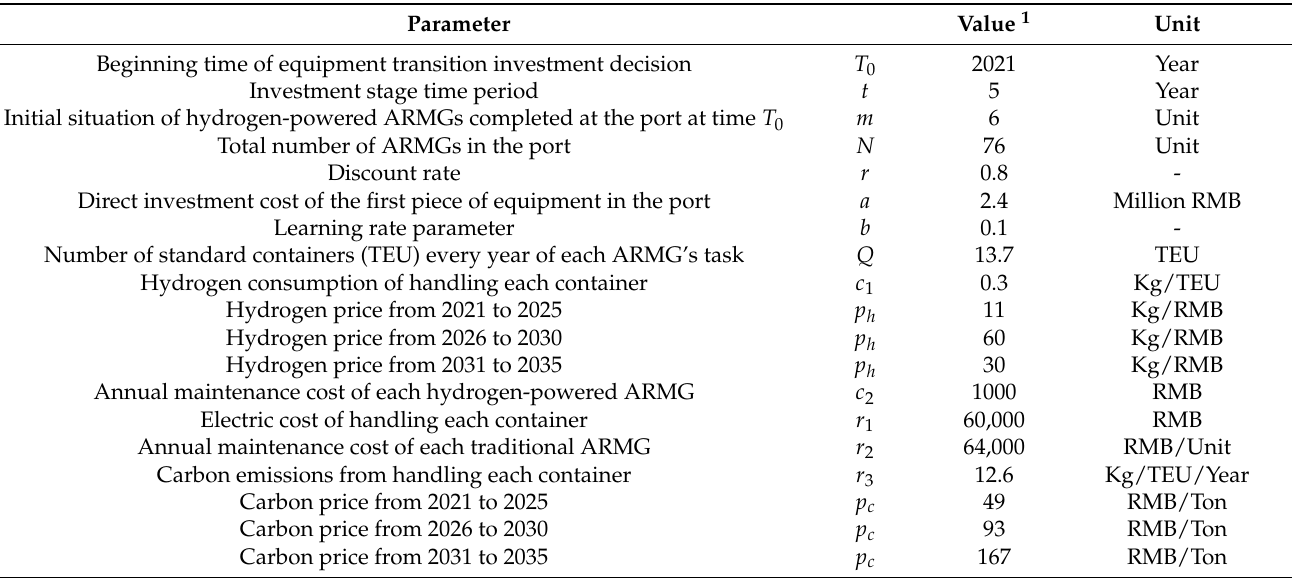
Table 3. Equipment transition